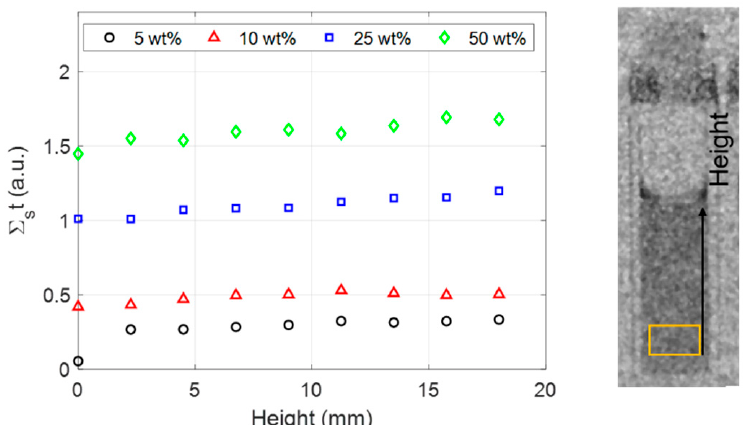
Figure 6. Total neutron scattering dependence on sample height. Right-hand-side illustration illustrates the ROIs utilized for height dependent data points.